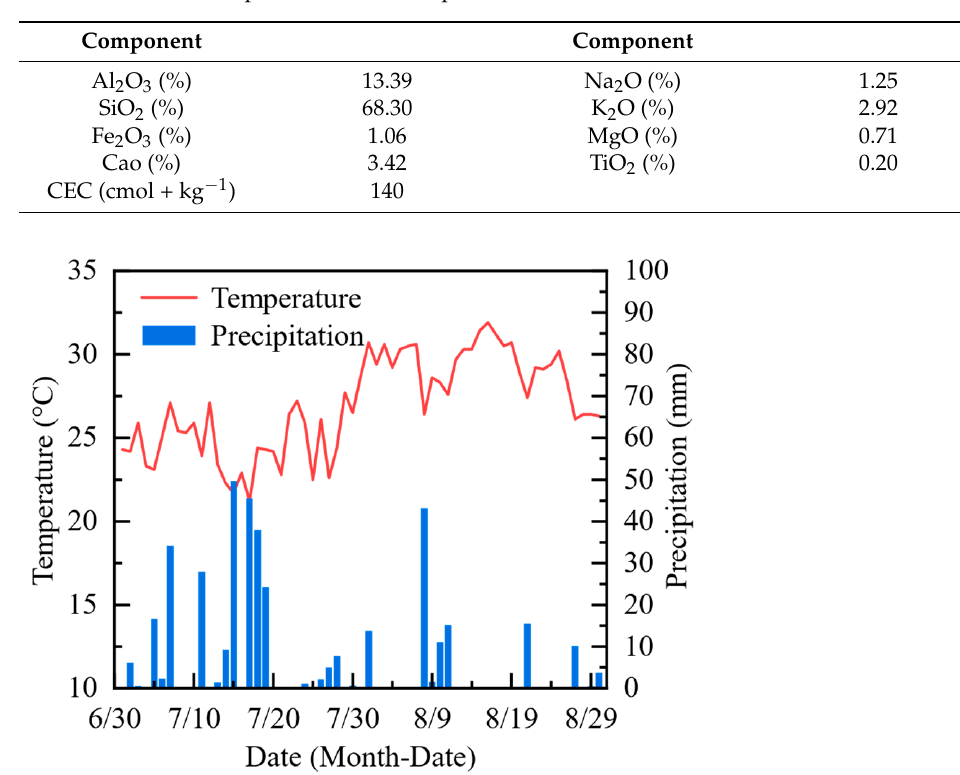
Table 1. Chemical composition of the clinoptilolite zeolite.